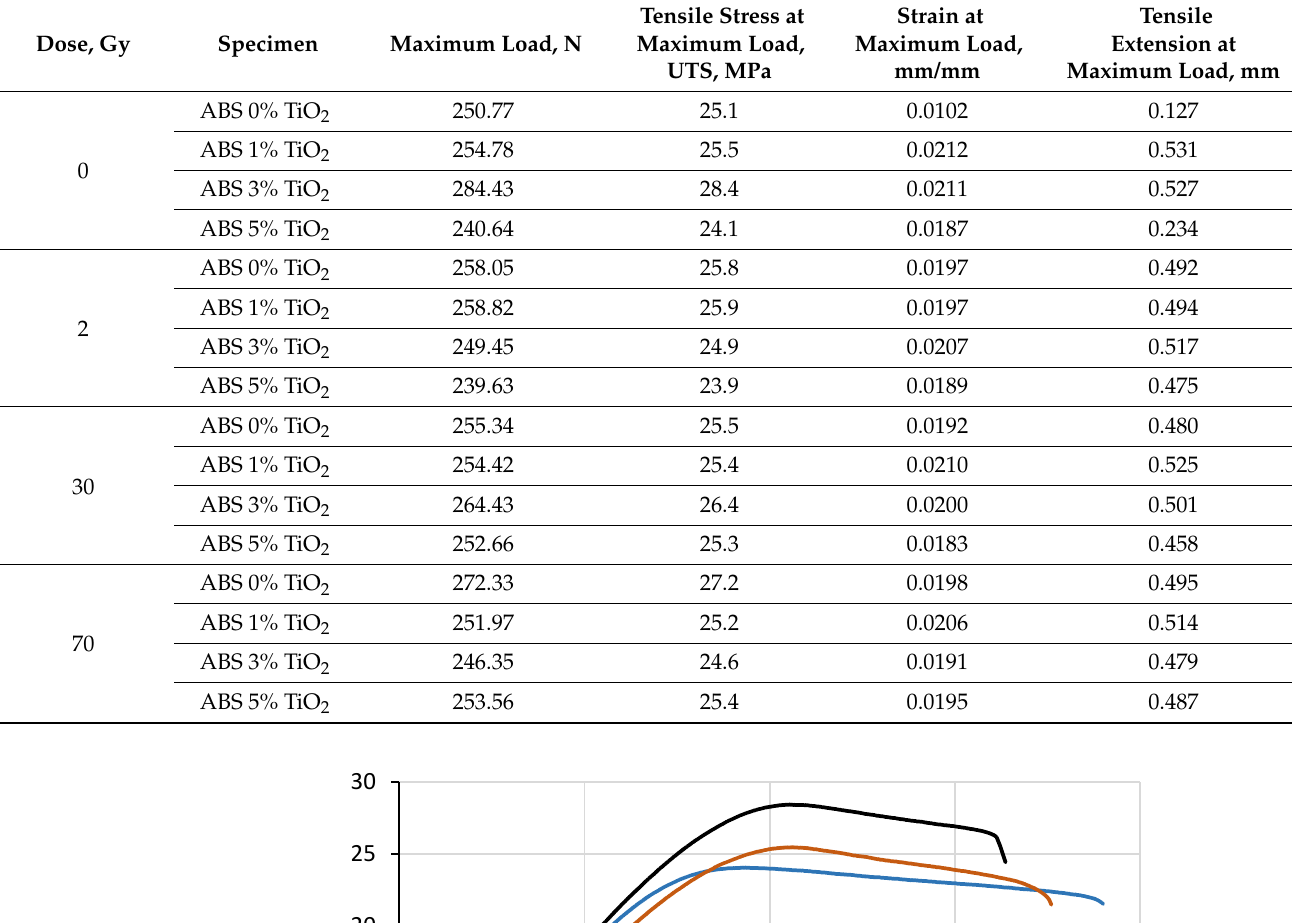
Table 4. Mechanical properties of the irradiated 3D printed composite samples.